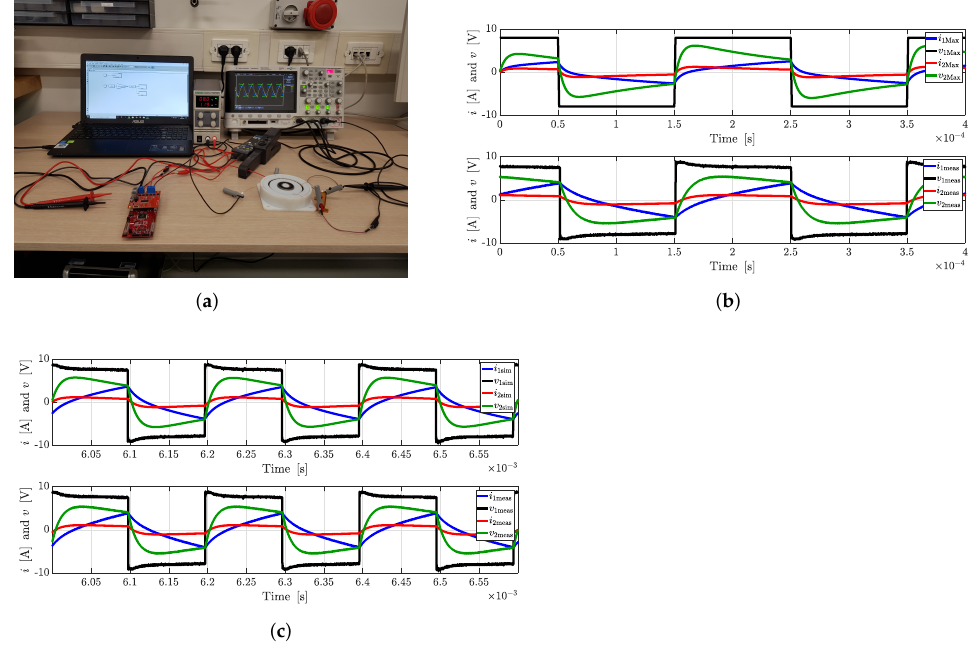
Figure 13. Experimental setup ( a ), comparison between the measured and simulated voltages and currents in ANSYS Maxwell ( b ) and comparison between measured and simulated voltages and currents in Simulink ® ( c ). In ( b , c ) the system is working at 5kHz. RMS values for i 1 , i 2 and v 2 are reported in Table 3.